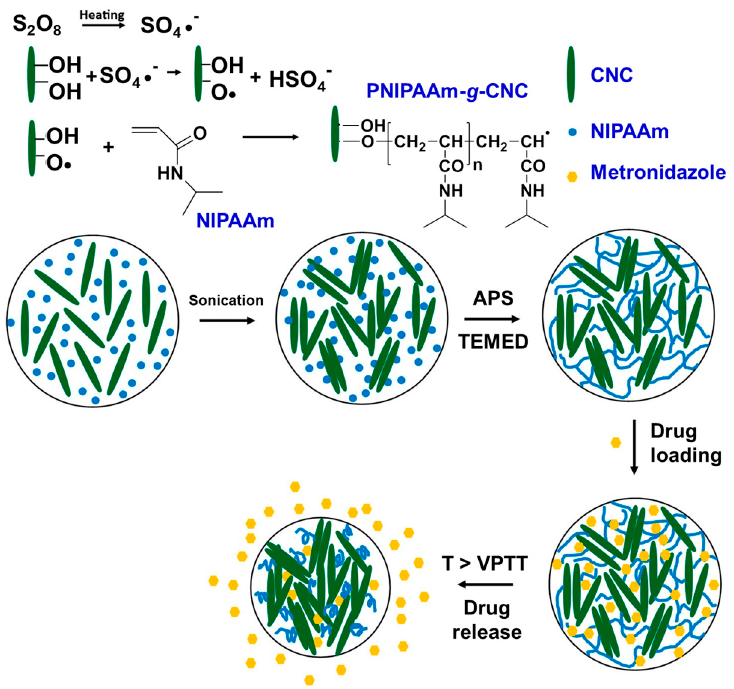
Figure 17. Graft copolymerization of NIPAAm and CNC via free radical polymerization employing ammonium persulfate (APS) as initiator and 1,2-di-(dimethylamino)ethane (TEMED) as accelerator ( up ) and schematic representation of metronidazole drug loading and release upon the action of the volume phase transition temperature (VPTT) at 37 °C ( down ). Adapted with permission from reference [52]. Copyright © 2017 Polymers MDPI.